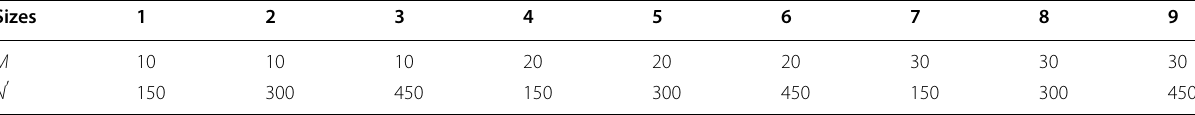
Table 4 The different sizes of the problem space